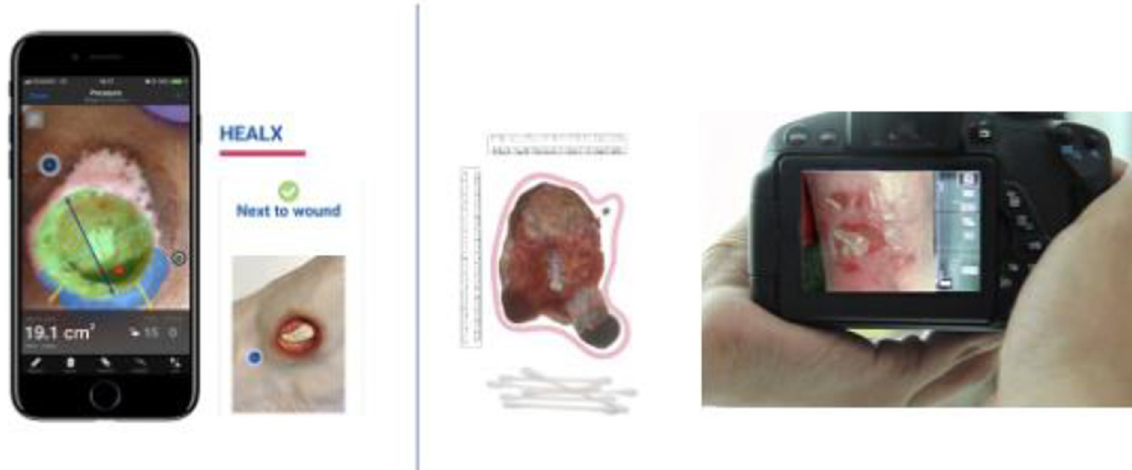
Fig 1. Swift software with fiducial marker (on the left) vs. traditional methods (right).